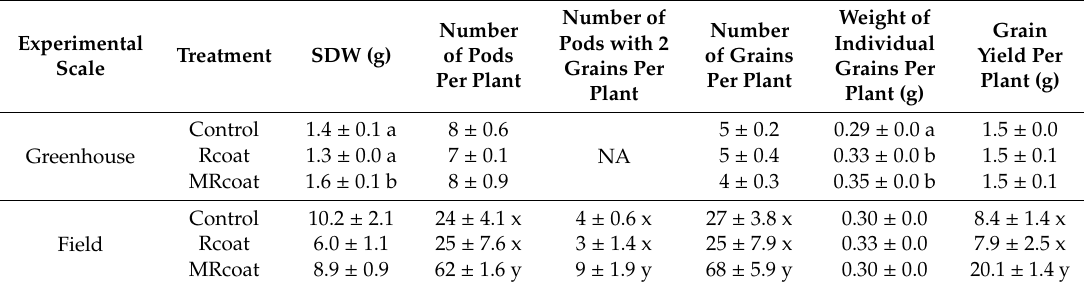
Table 1. Growth and productivity parameters of chickpea in di ff erent inoculation treatments (control, Rhizophagus irregularis (Rcoat), a mixture of R. irregularis isolates (MRcoat)) under greenhouse and field